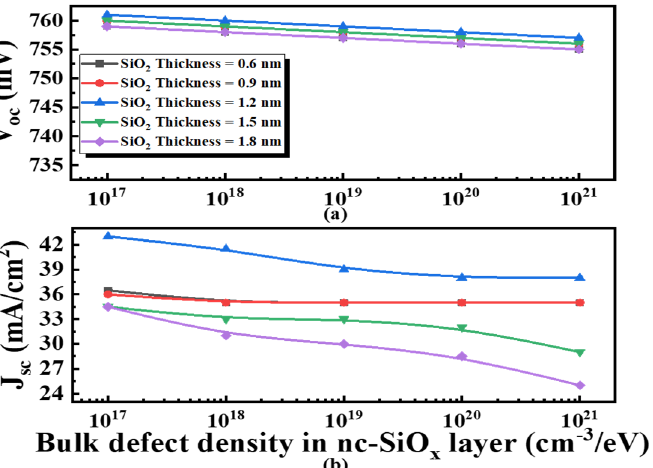
Figure 8. Effect of various bulk-defect density (1 × 10 17 –1 × 10 21 cm − 3 ) with various oxide thicknesses (0.6–1.8 nm) on ( a ) V oc and ( b ) J sc on the TOPCon solar cell.